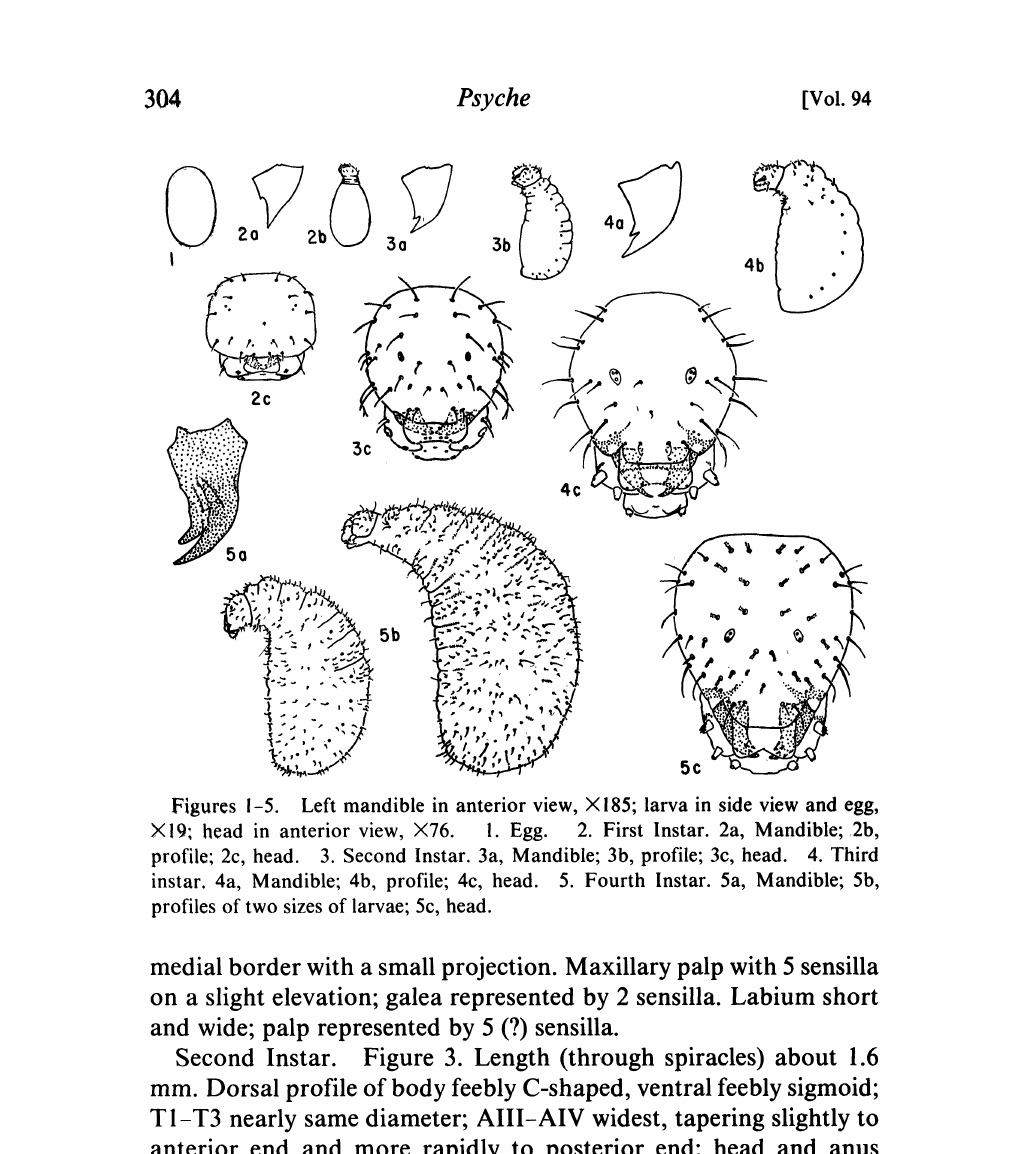
Figure 3. Length (through spiracles) about